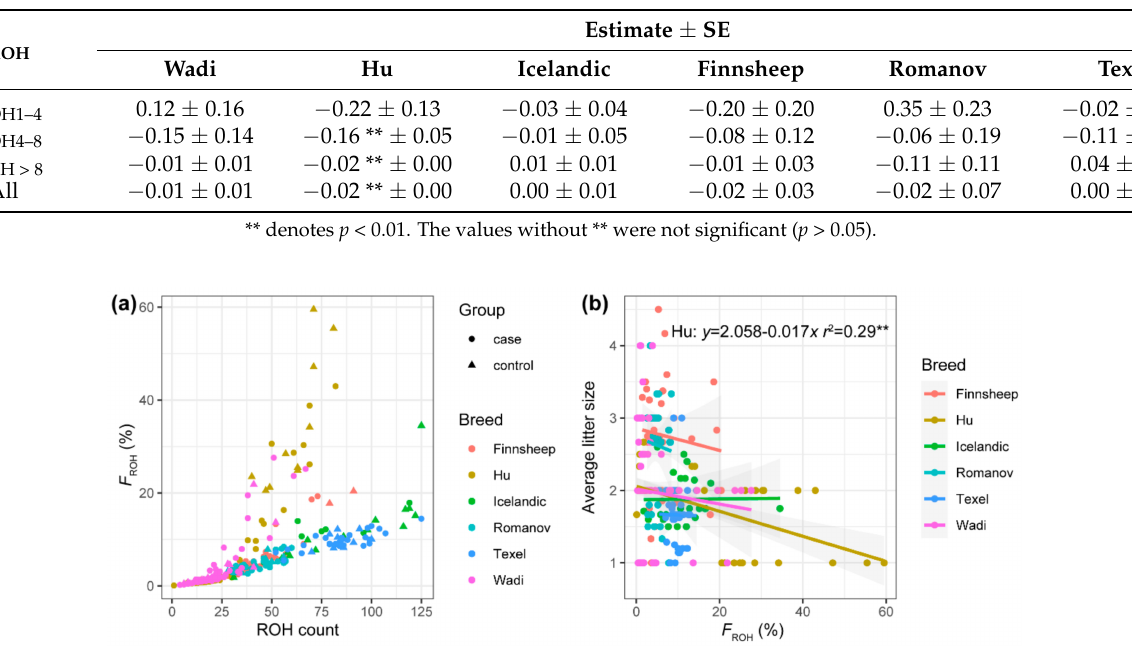
Table 3. Estimates of inbreeding depression for average litter size, expressed as the change in expected phenotype per 1% increase inbreeding.